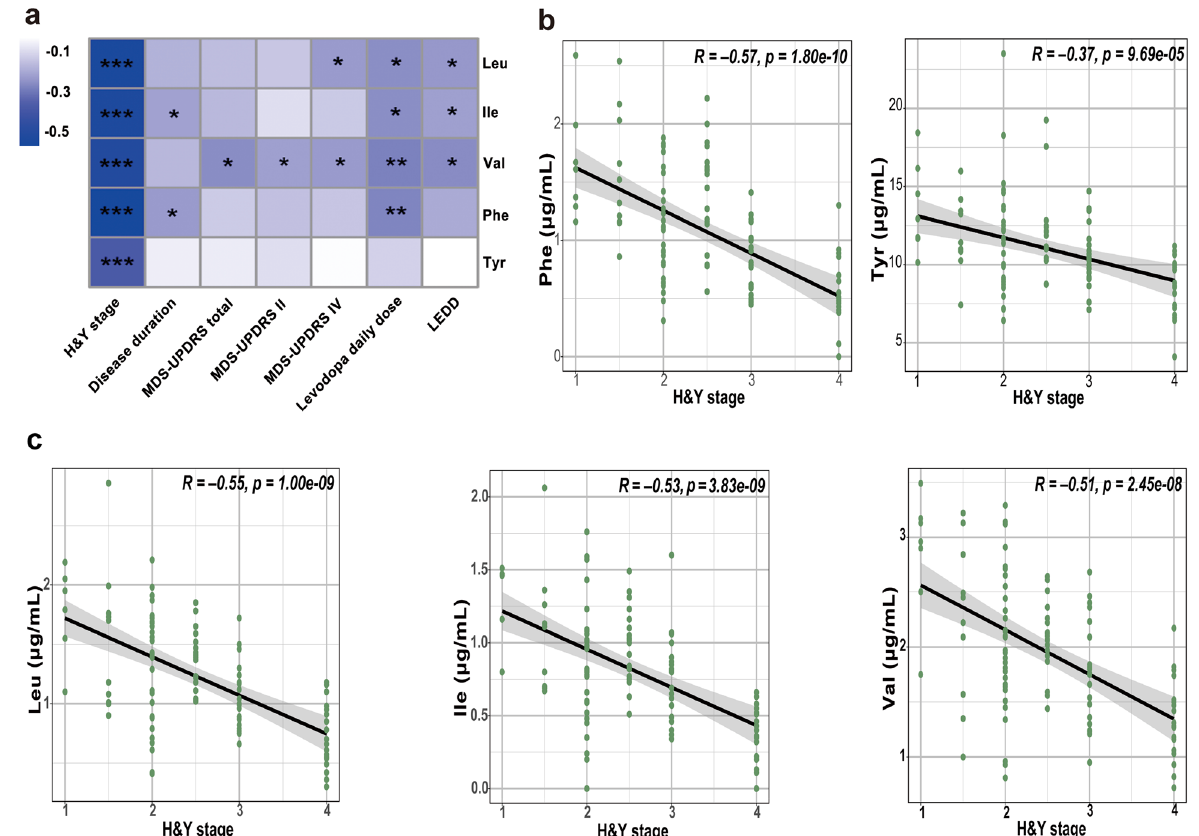
Fig. 1 Correlations between plasma BCAAs and AAAs and PD clinical characteristics. The heat maps represent Spearman ’ s rank correlations of BCAAs and AAAs with PD clinical characteristics ( a ). Correlation coef fi cients are represented by gradient colors. * P < 0.05, ** P < 0.01, and *** P < 0.001. Scatter plot of plasma AAAs ( b ) and BCAAs ( c ) vs. H&Y stage. BCAAs, branched-chain amino acids; AAAs, aromatic amino acids; Leu, leucine; Ile, isoleucine; Val, valine; Phe, phenylalanine; Tyr, tyrosine; MDS-UPDRS, Movement Disorder Society-sponsored revision of